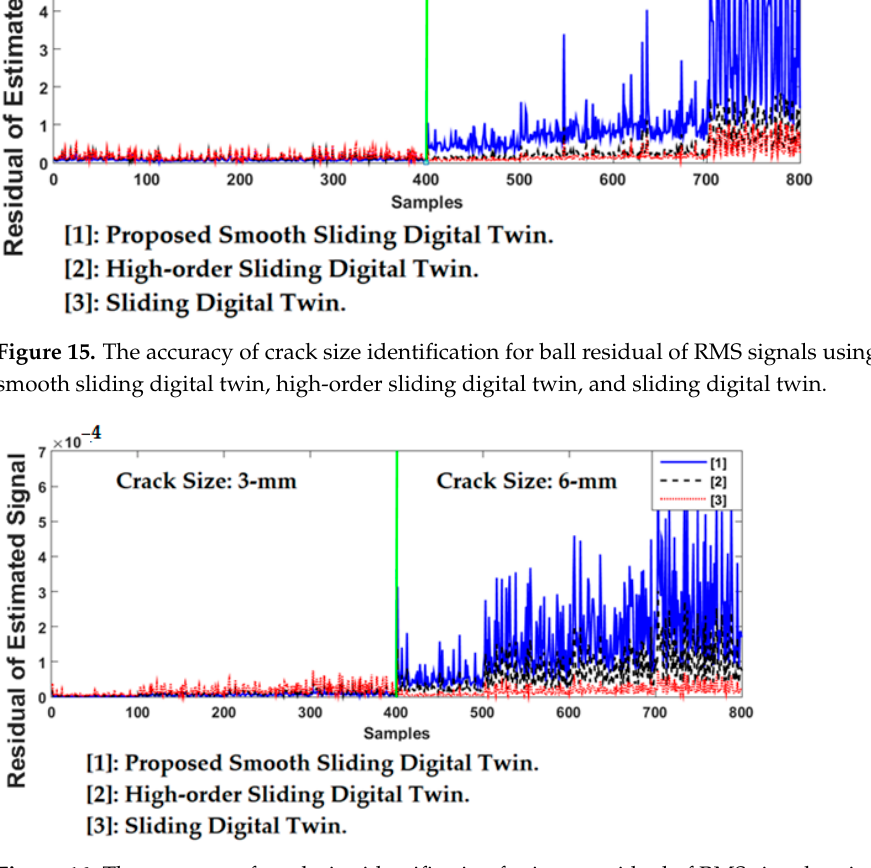
Figure 16. The accuracy of crack size identification for inner residual of RMS signals using proposed smooth sliding digital twin, high-order sliding digital twin, and sliding digital twin.